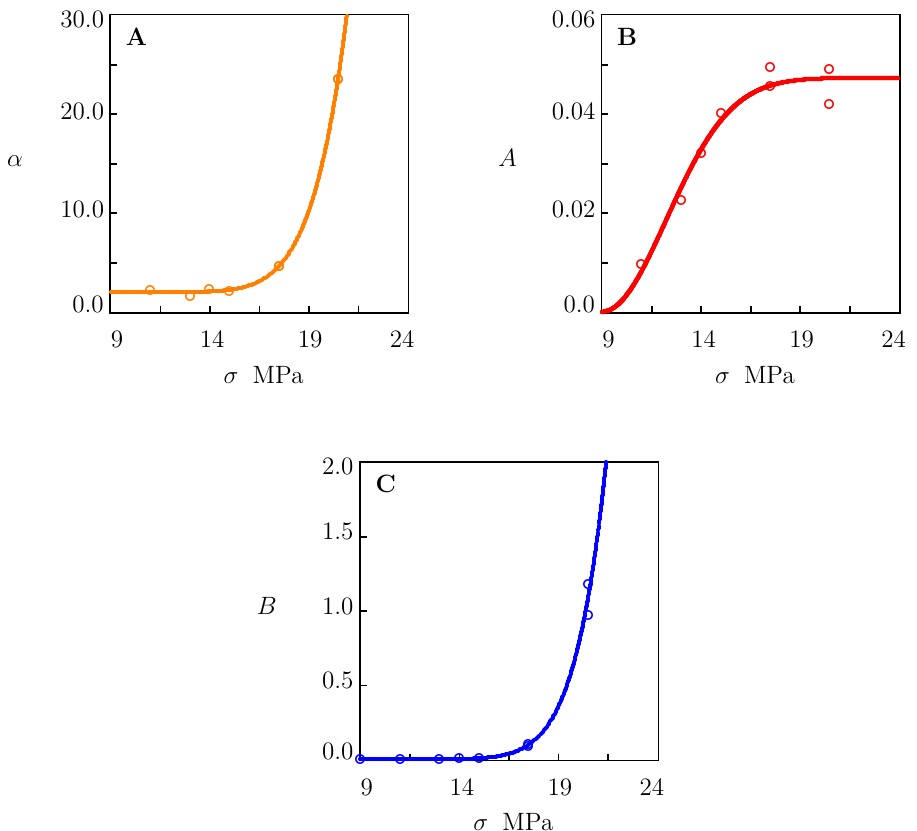
Figure 5. Parameters ( A ) α , ( B ) A , and ( C ) B versus tensile stress σ . Circles: treatment of experimental data in creep tests. Solid lines: results of numerical analysis.